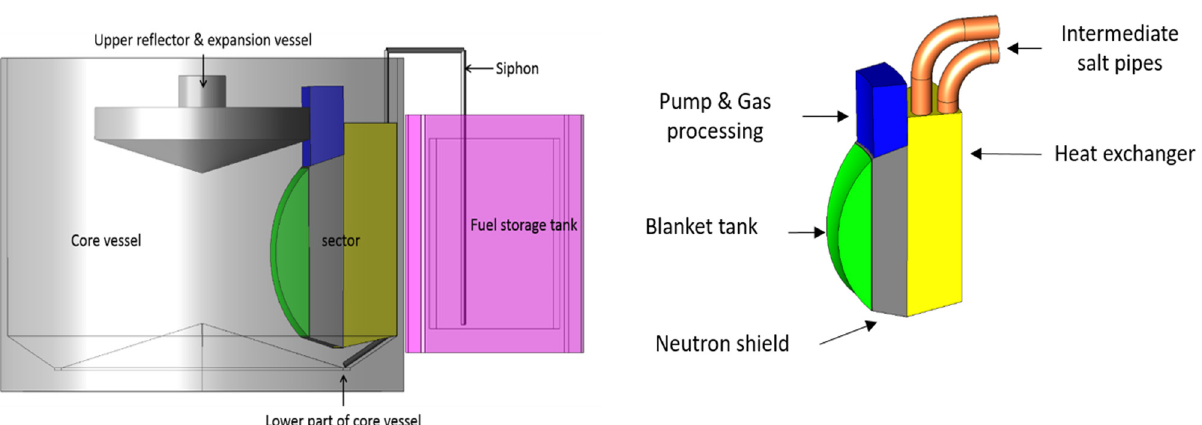
Fig. 1. Schematic representation of the core vessel with one cooling sector (left) and description of a sector